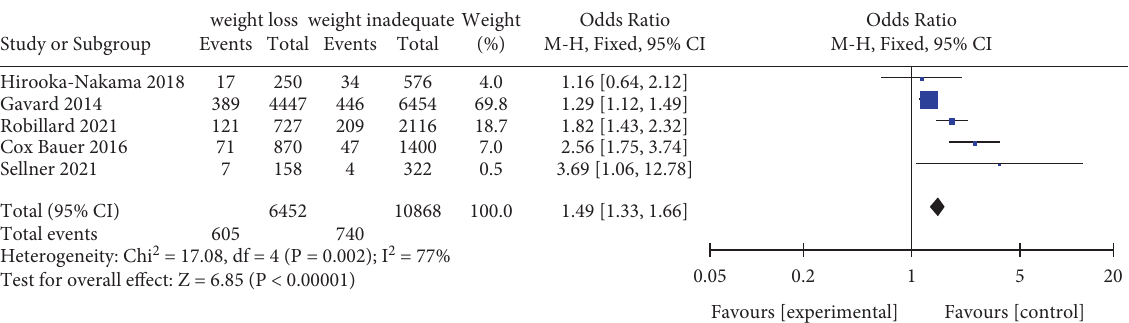
Figure 7: Forest plot of weight loss and inadequate weight with SGA for obese women.